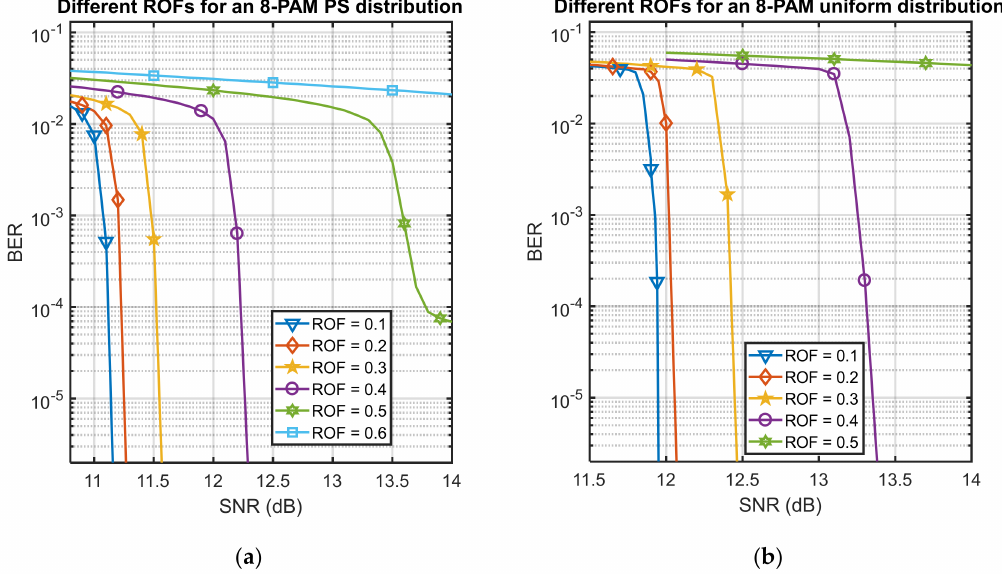
Figure 5. BER performance for di ff erent ROF values for: ( a ) a PS distribution with an LDPC code of rate r = 0.8 and ( b ) a uniform distribution with an LDPC code of rate r =